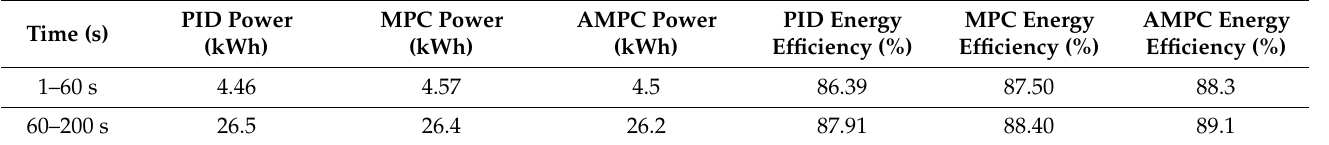
Table 1. Energy consumption and energy efficiency of heated saline using PID, MPC, and AMPC controller.